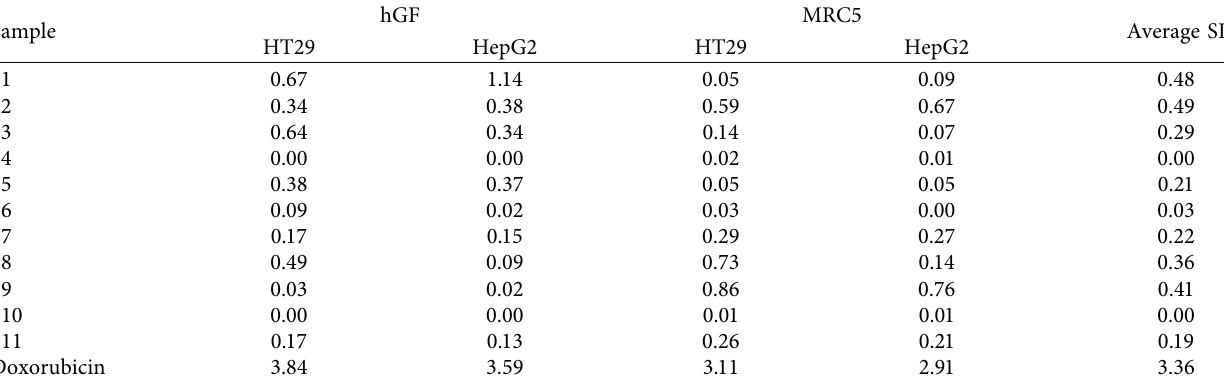
Table 4: Selectivity of the eleven SLTextracts and doxorubicin against HT29 and HepG2 cancer cells compared with hGF and MRC5 normal